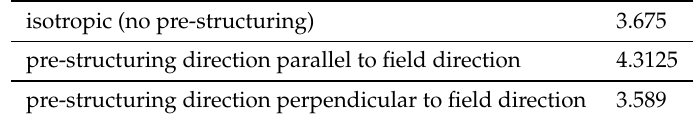
Table 2. Permeabilities µ used for our magnetostatic simulations; based on initial gradients (up to 50kAm − 1 ) from experimental data.